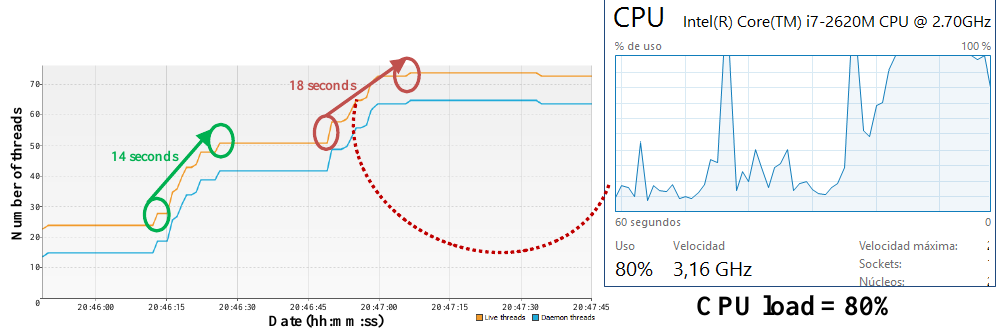
Figure 14. CPU load vs . application start time.